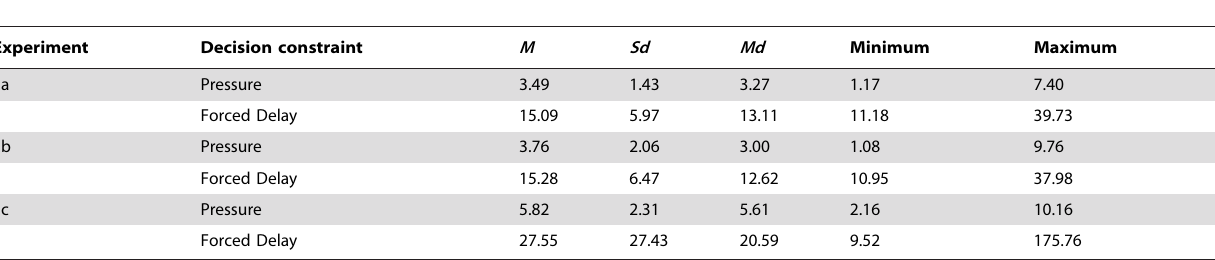
Table 5. Mean ( M ), Standard Deviation ( Sd ), Median ( Md ), Minimum and Maximum of the Decision Times per Decision Constraint Condition for Experiments 2a, 2b and